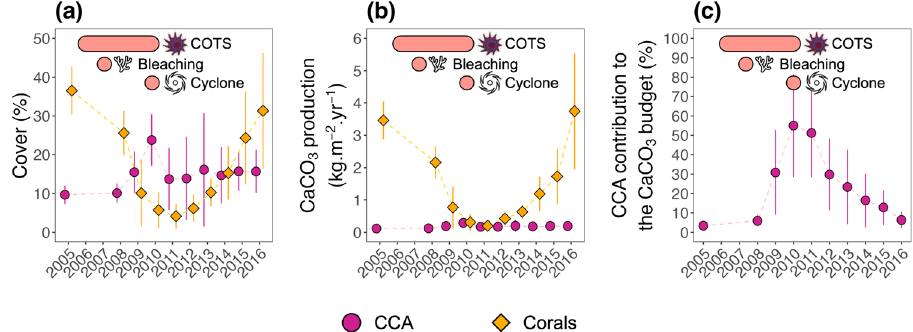
Fig. 5 Case study of CCA contribution to the Mo ’ orea reef carbonate budget. a Annual mean ± SD% cover of CCA (pink circles) and coral (orange) diamonds are reported for the fore reef of Mo ’ orea, French Polynesia 118 before, during, and after a series of disturbance events including a crown-of-thorns star fi sh outbreak from 2006 – 2010, a coral bleaching event in 2007, and Cyclone Oli in 2010 25 . b The respective % cover from panel a were multiplied by CCA calci fi cation rate for CCA and by coral calci fi cation rate from Fig. 2 x reef-scale rugosity for corals 119 to determine mean ± SD community-level, area- normalised CCA and coral calci fi cation rates. c The mean ± SD% contribution of CCA to the total CaCO 3 budget (i.e., total G = CCA G + coral G) are reported for each